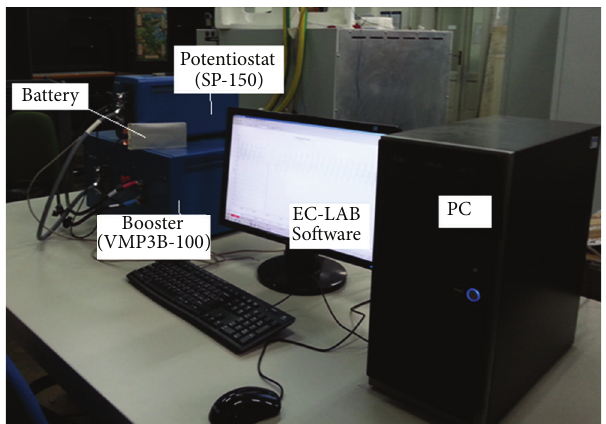
Figure 2: Experimental